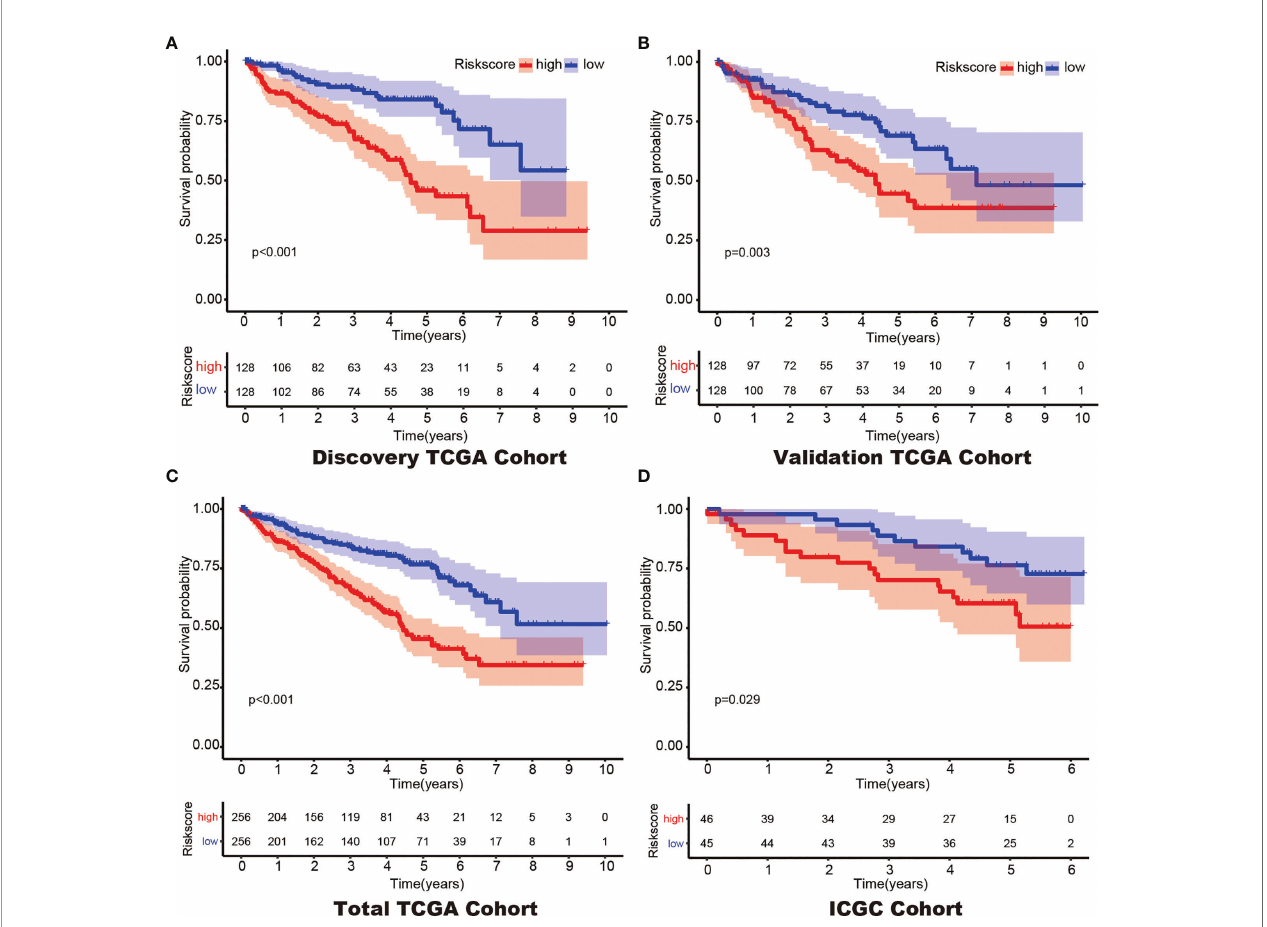
FIGURE 3 | Kaplan – Meier survival of the 6-gene prognostic model in the Discovery TCGA Cohort (A) , the Validation TCGA Cohort (B) , the Total TCGA Cohort (C) and the ICGC Cohort (D)